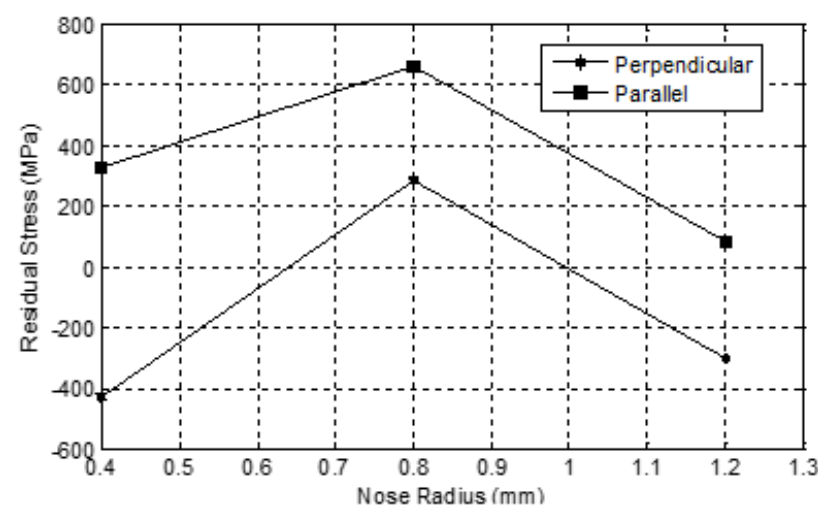
Figure 8: Residual stresses, different nose radii, coated